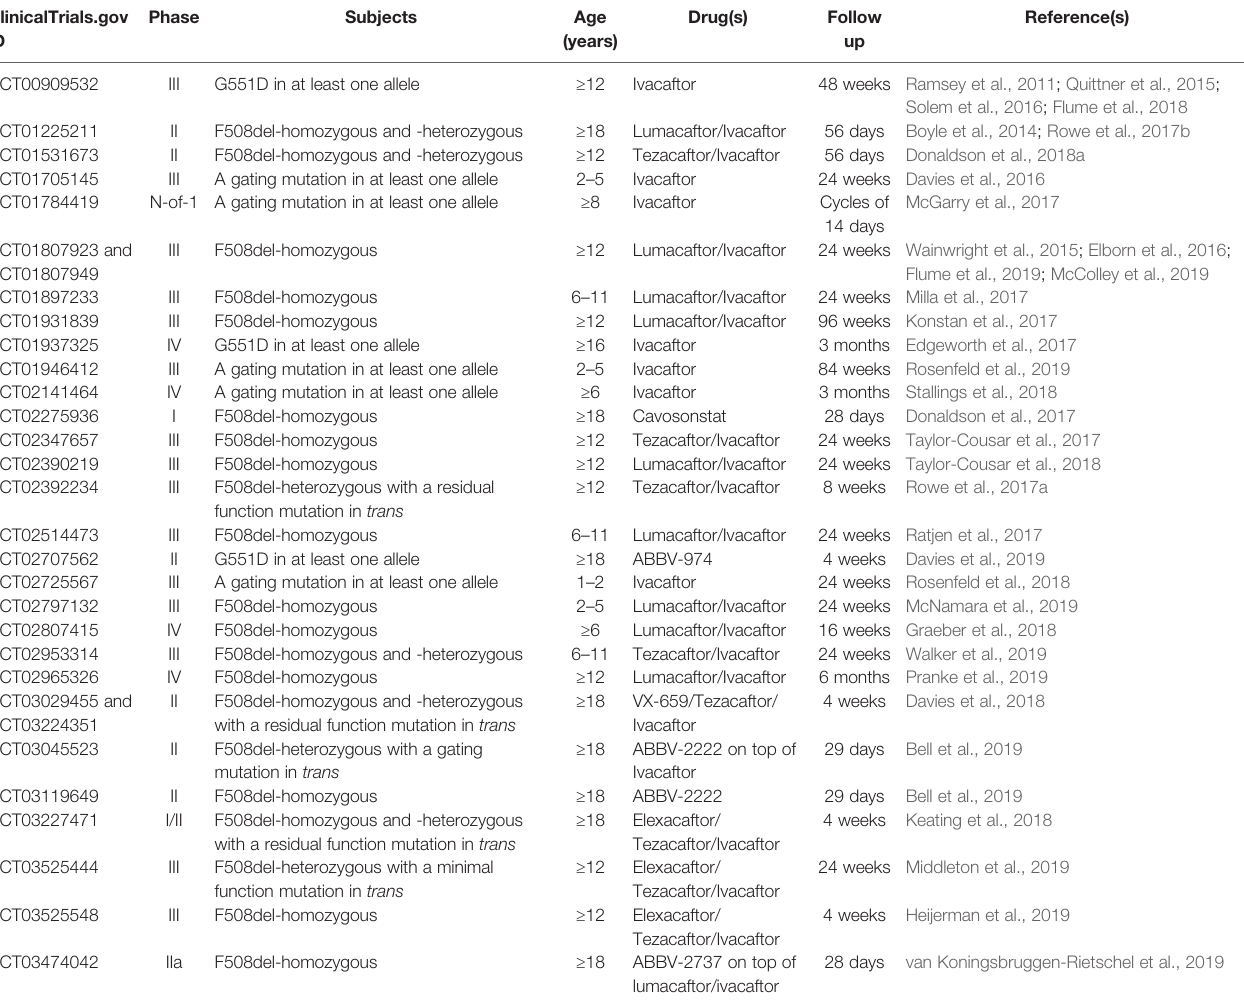
TABLE 1 | Publications evaluating safety and ef fi cacy and post-approval observational studies of CF transmembrane conductance regulator (CFTR) modulators in CF patients (*). ClinicalTrials.gov